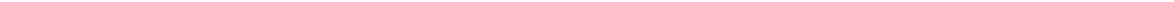
Fig. 8 Anatomical characterization of L2 – L5 interneurons in the adult rat spinal cord. a Bilateral injections of FluoroRuby (not shown) and FluoroEmerald (shown alone for clarity; b , injection site) were performed to retrogradely label L2 – L5 interneurons for light sheet fl uorescence microscopy ( N = 3). c Cleared L2 segment (c.c. central canal, R-C rostrocaudal). d , e 100 µ m cross-section. f Average number of FluoroEmerald-labeled L2 – L5